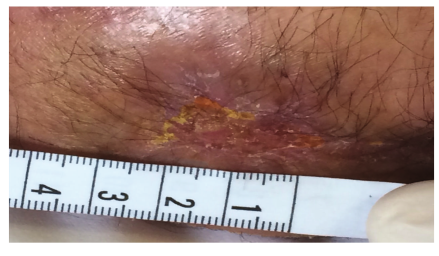
Figure 5: Stage V at 5th week.